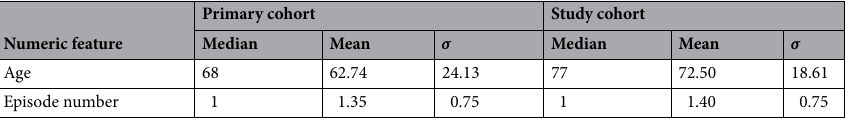
Table 3. Statistical quantitative description of the numeric features. Primary cohort full sample: 110,204 admissions. Study cohort full sample: 19,051 admissions. σ : standard deviation.